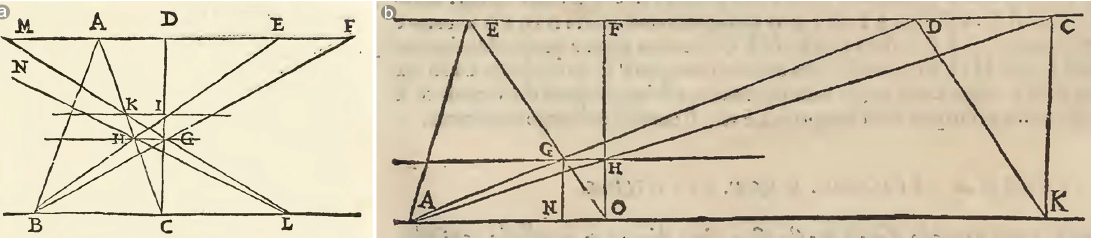
Figure 6. The figure of Danti’s VI annotation ( a ), in the sixth chapter introducing the first rule, shows how it is possible to identify the perspective of the back side of a square even if we make a translation of the overturned point of distance and picture plane. The same principle had already been demonstrated in the first part of theorem III through a flat geometry exercise ( b